Question: Condense the content of this figure into a single sentence.
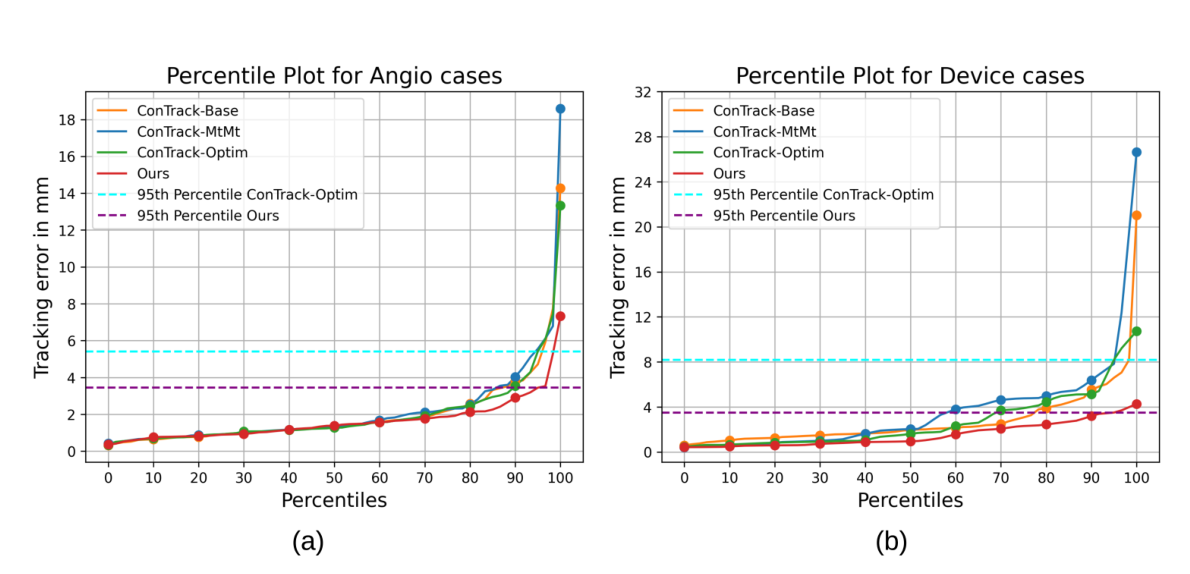
Answer: Percentile plots of different versions of ConTrack and Ours for (a) Angio Cases and (b) Device cases.